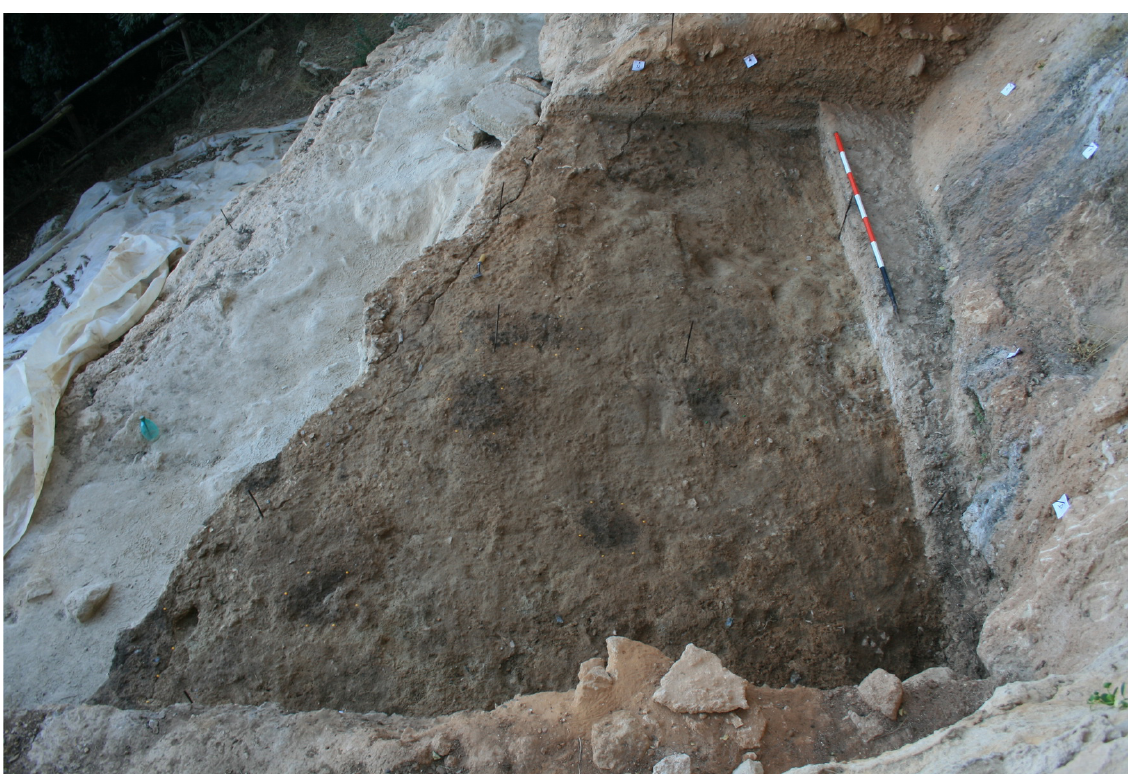
Figure 3. The top of SU 13. (Photo by P.